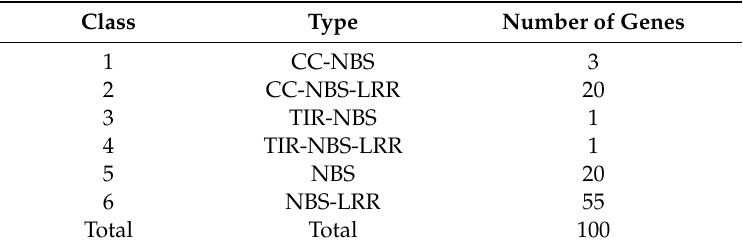
Table 1. Classification of the Nucleotide-binding site and leucine-rich repeat (NBS-LRR) genes in the kiwifruit genome.